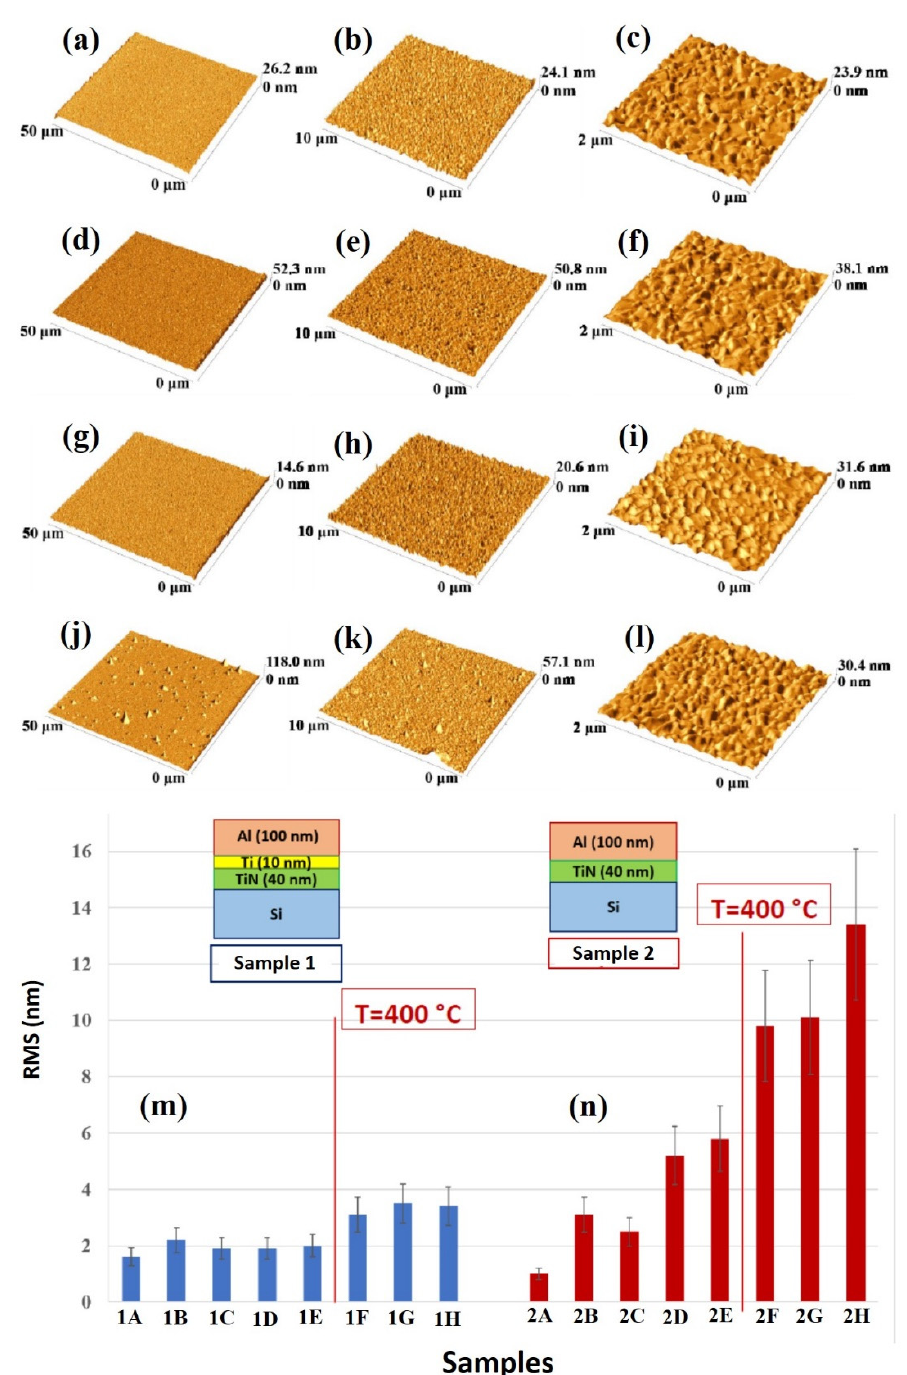
Figure 8 . Representative AFM images (three-dimensional reconstructions) of the Al surface for the sample: ( a – c ) 1A (Si/TiN/Ti/Al) with decreasing scan size from ( a ) to ( c ); ( d – f ) 1H (Si/TiN/Ti/Al + 500 °C 15 min) with decreasing scan size from ( d ) to ( f ); ( g – i ) 2A (Si/TiN/Al) with decreasing scan size from ( g ) to ( i ); ( j – l ) 2H (Si/TiN/Al + 500 °C 15 min) with decreasing scan size from ( j ) to ( l ). ( m ) reports the Al layer surface roughness, as quantified by RMS through the AFM measurements and calculated by the 50 μ m scan size images, for samples of class 1 (Si/TiN/Ti/Al) in the various thermal processing conditions. ( n ) reports the Al layer surface roughness, as quantified by RMS through the AFM measurements and calculated by the 50 µ m scan size images, for samples of class 2 (Si/TiN/Al) in the various thermal processing